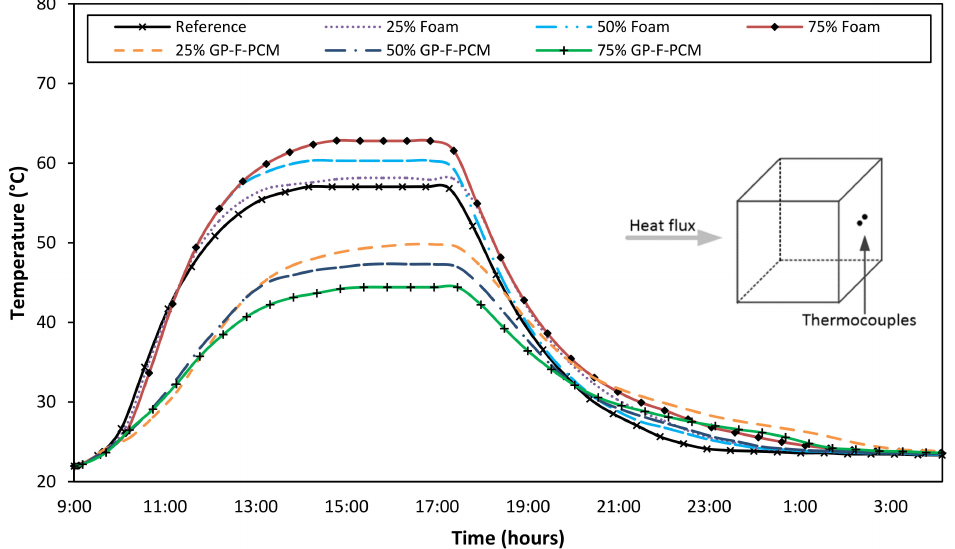
Figure 5. Back-surface temperature